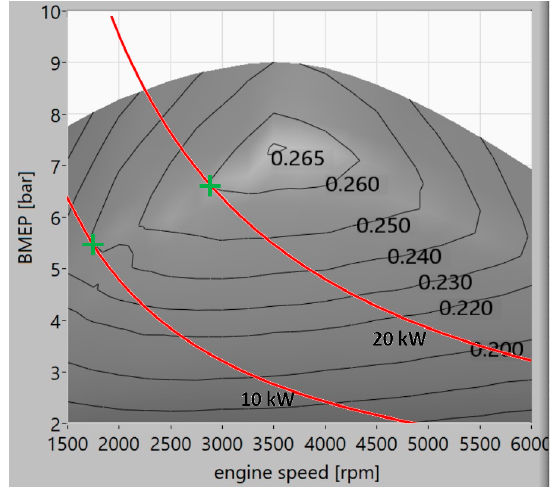
Figure 5. The best efficiency points at constant required power (gasoline).